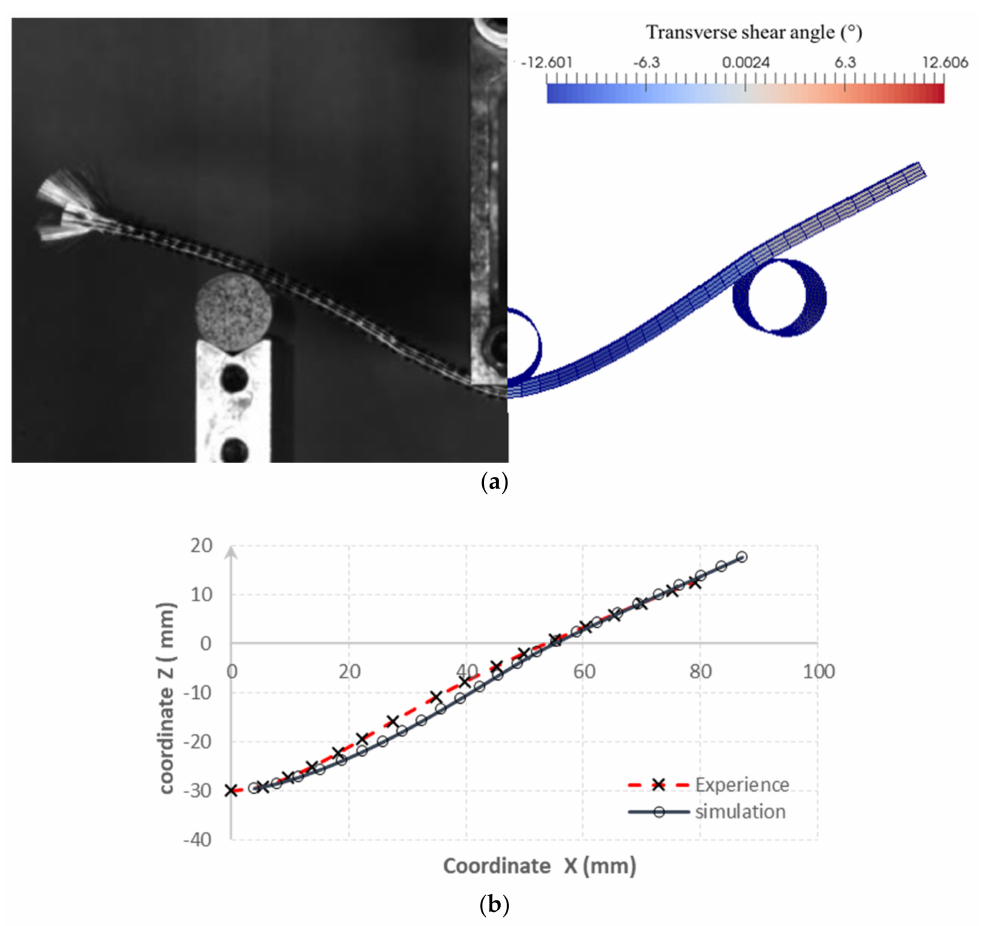
Figure 2. Comparisons between the numerical and experimental results for three-point bending ( a ) deformed geometry and ( b ) the deformation of the middle line of the